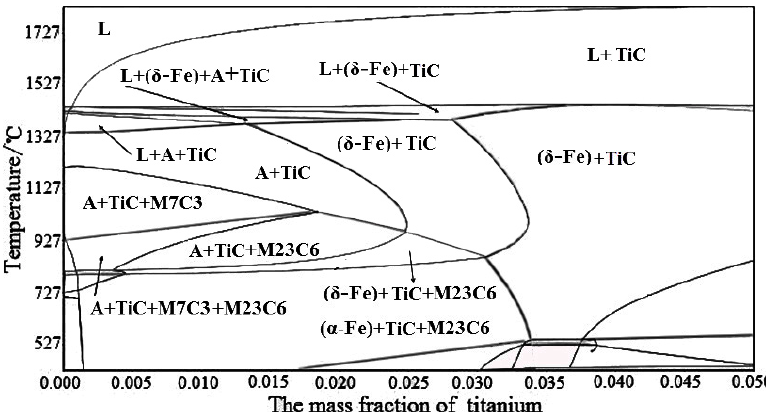
Figure 11. Equilibrium phase formation of 8Cr13MoV steel calculated using Thermo ‐ Calc: L ‐ Liguid, ( δ‐ Fe) ‐ ( δ‐ Ferrite), A ‐ Austenite, ( α‐ Fe) ‐ ( α‐ Ferrite).